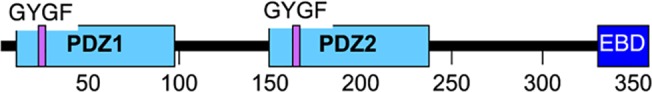
Schematic representation of NHERF1.NHERF1 possesses two tandem PDZ domains and a carboxy-terminal ezrin binding domain (EBD).